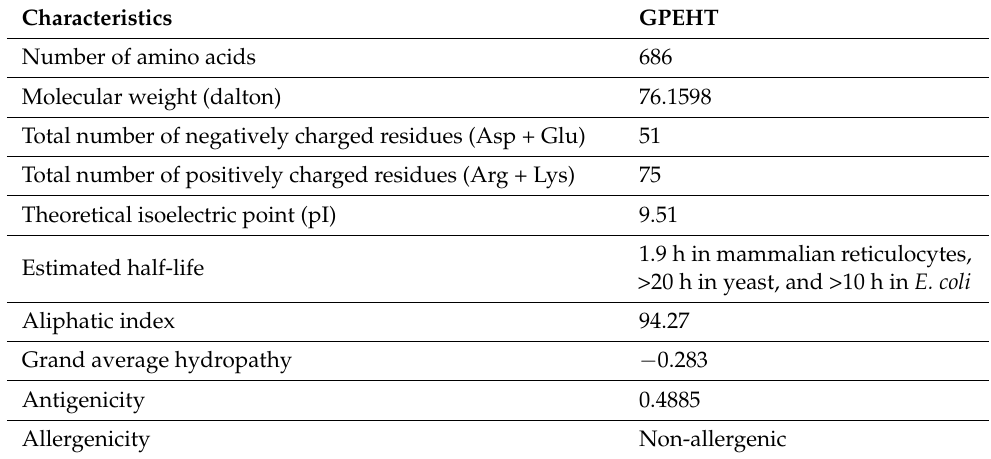
Table 1. The physicochemical parameters, antigenicity, and allergenicity of GPEHT protein.